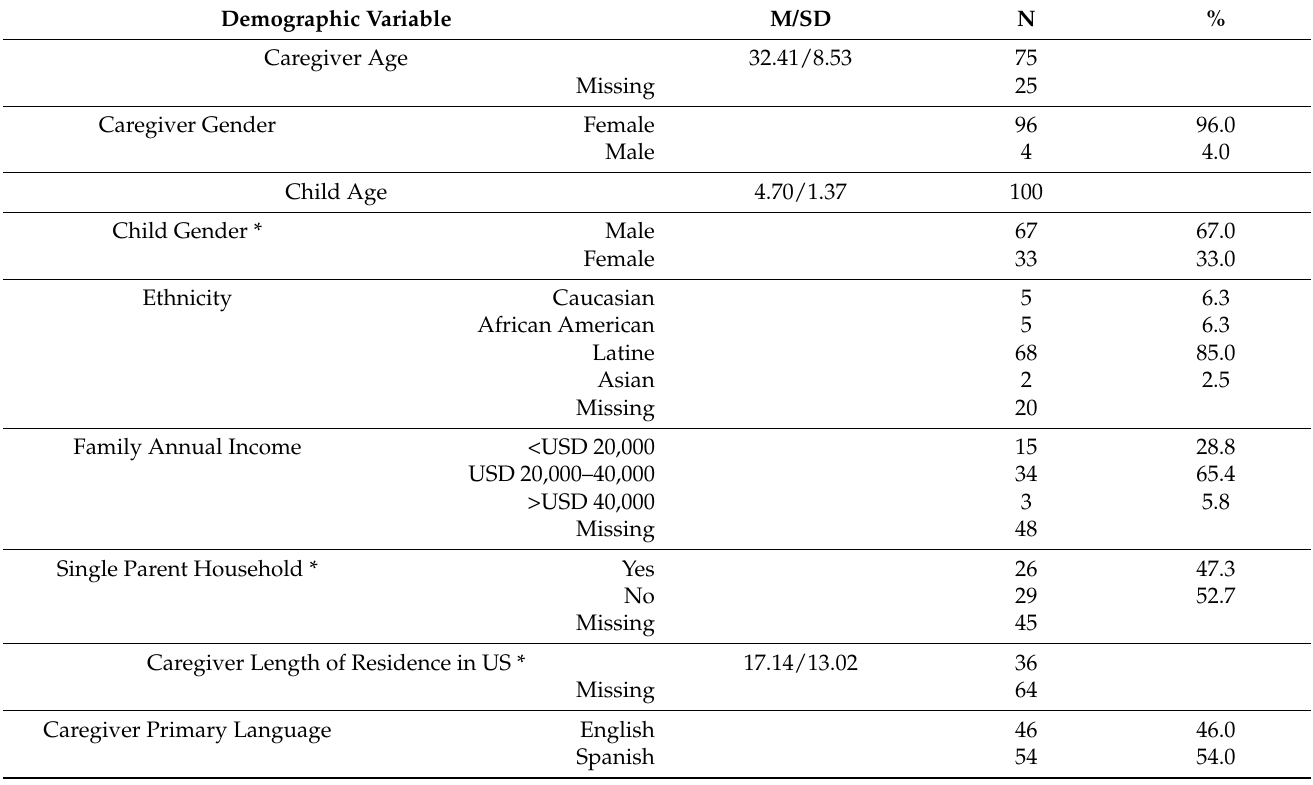
Table 1. Demographic characteristics for parent–child